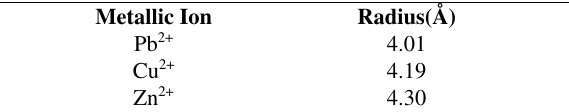
Table 5. Hydrated ion radii.